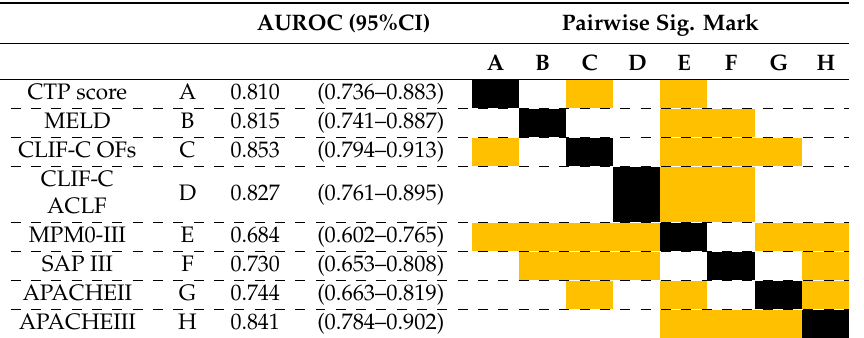
Table 3. Comparison of the 8 prognostic scores to predict 28-day mortality by